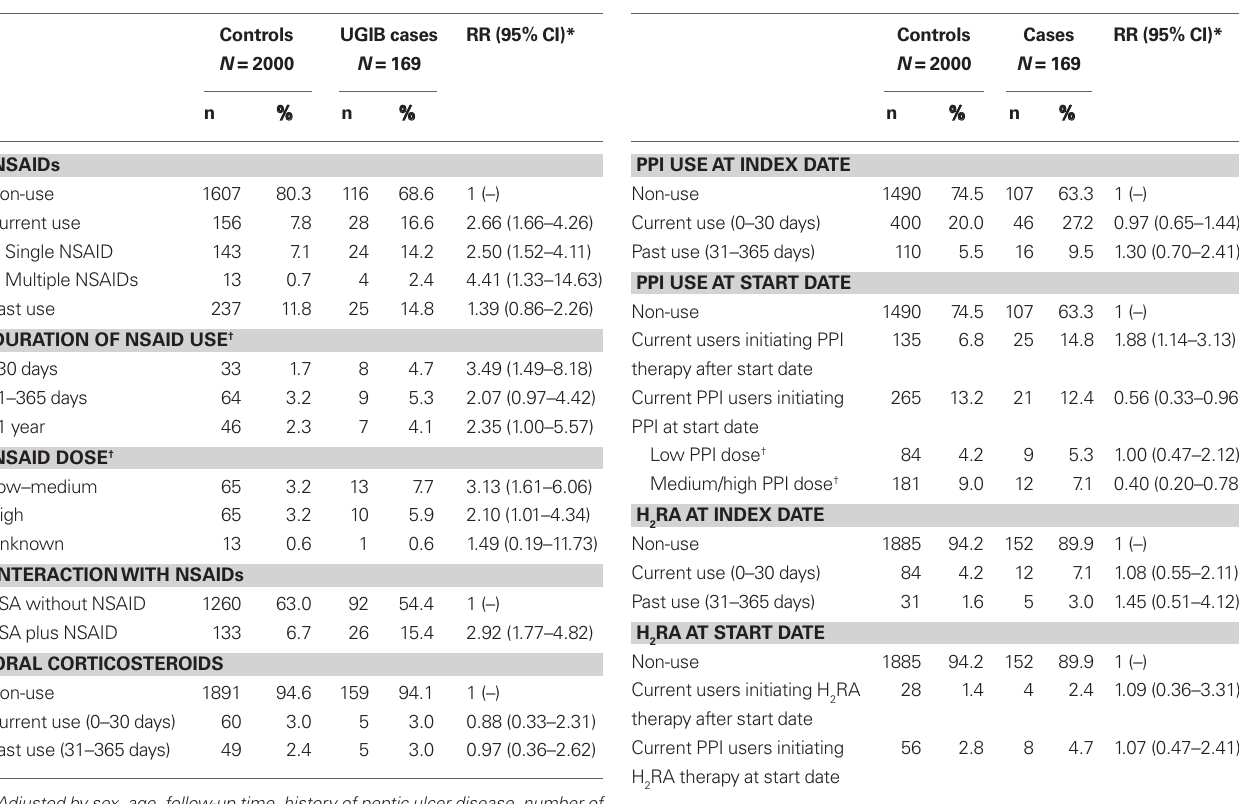
Table 5 | PPi and h rA use in individuals with ugiB and controls with 2 no ugiB, and its association with a diagnosis of ugiB, in a cohort of low-dose ASA